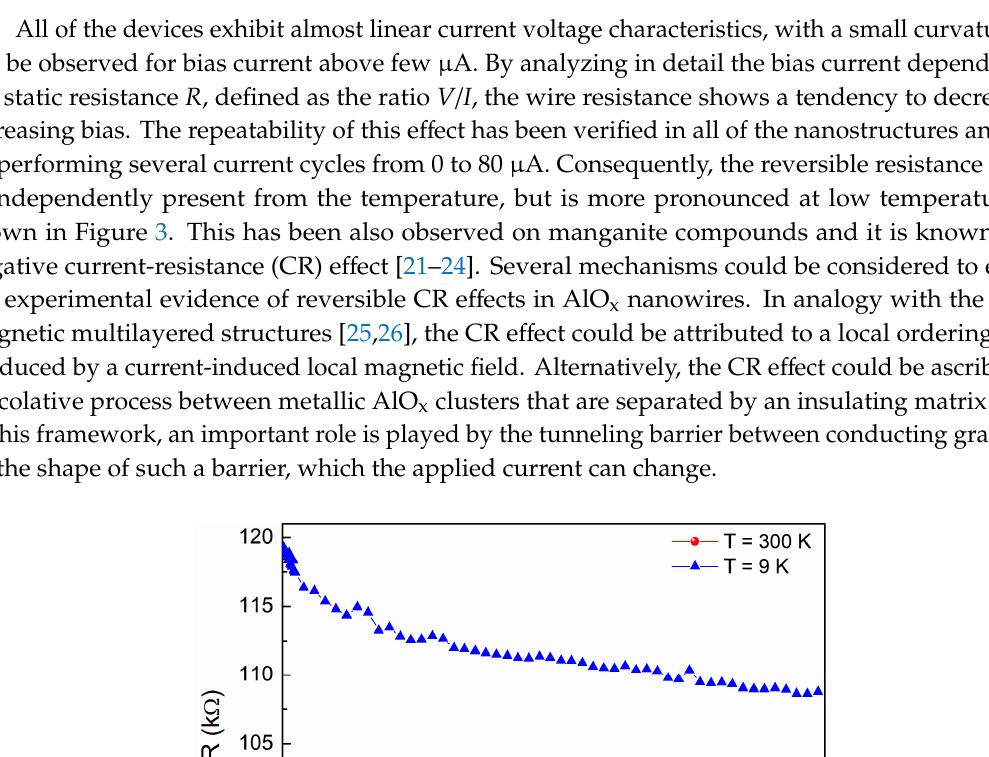
Figure 2. Resistance versus temperature plots. The data refer to five investigated devices. The solid lines are obtained by interpolating the experimental points and they are guides for the eyes.